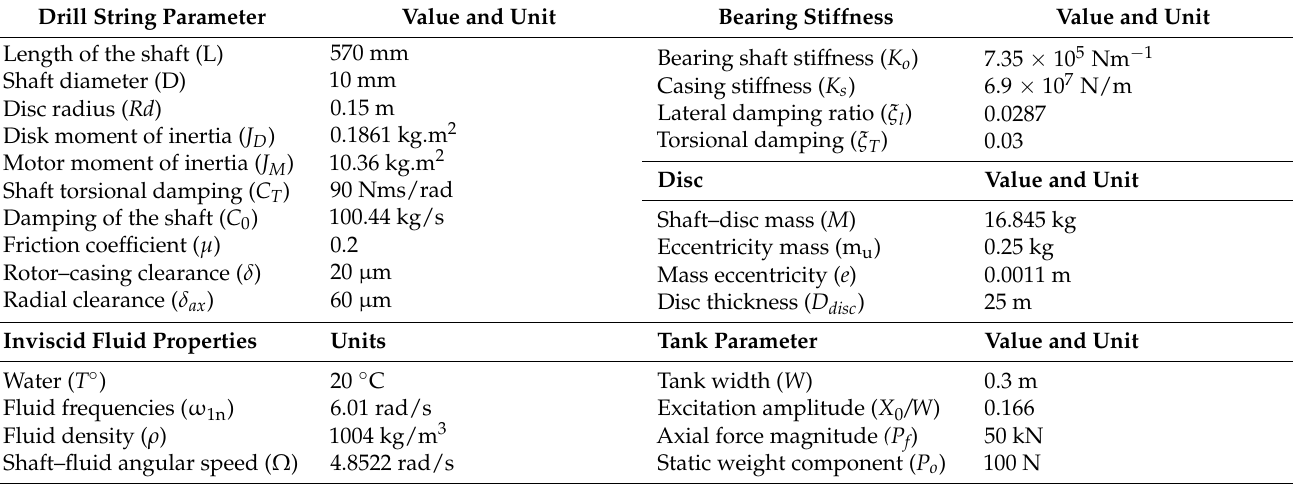
Figure 6. Dependence of the ratio of the hydrodynamic forces on the damping and frequency parameters. ( a ) Fluid forces for various values of ξ ; ( b ) Fluid forces around the oscillating drill. From Figure 6a, it can be seen that an underdamped fluid system between 0.1 and 0.9 gets close more rapidly than a critically damped or overdamped system. When increasing the damping parameters, the amplitude of the hydrodynamic force is exponentially increased away from the equilibrium position. The hydrodynamic forces acting on the rectangular container experience harmonic motion by overshooting the equilibrium position rapidly and exhibiting the fastest unstable response. Overdamped hydrodynamic forces are sluggish in responding to any damping increment, as observed by the dashed curves. However, Figure 6b presents the dependence of fluid forces on the lateral excitation frequency. From the foregoing analysis of the hydrodynamic forces, the fluid force is either critically damped or overdamped monotonically at the same magnitude. The downhole vibration of a drill bit, such as axial, lateral, and torsional vibrations, can cause premature tool failure. To optimize the drilling performance and extend the life of the drilling tools, controlling or mitigating downhole vibration is essential [19,20]. The natural frequencies of the five DoF kinematic chain are as follows: f 01 = 0 Hz, f 02 = 4.0756 Hz, f 0X =53 Hz, f 0Y = 53 Hz, and f 0Z =187 Hz. The fluid drill string parameters used in this study are listed as indicated in Table 1. Table 1. Data parameters used in rotary drilling simulation.